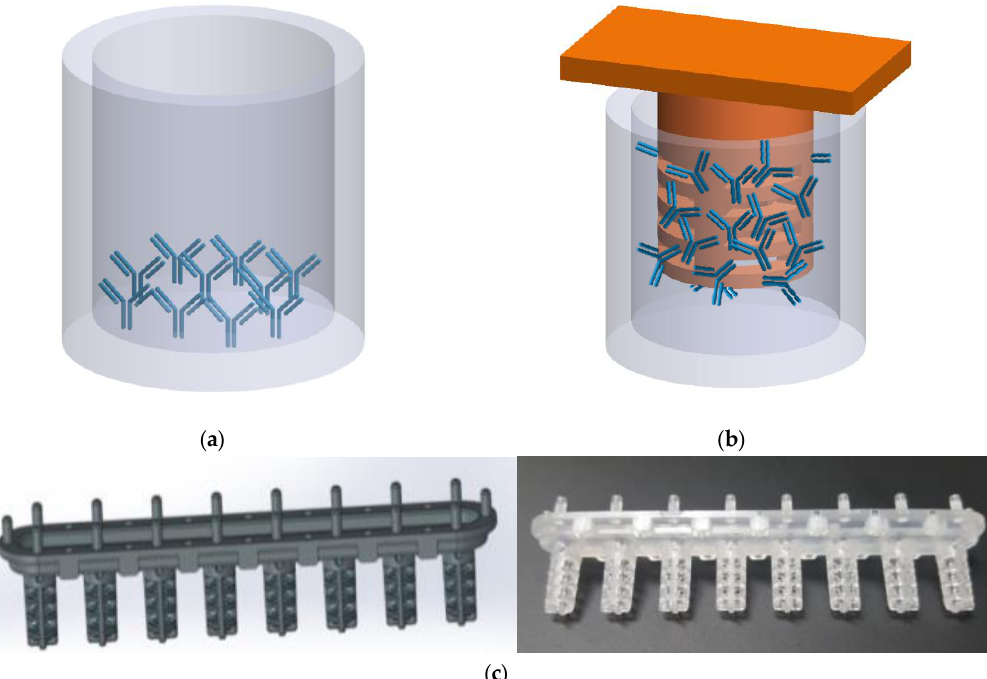
Figure 1. Schematic of plastic membrane design for this study. ( a ) Most antibodies are conjugated on the bottom surface in a conventional ELISA well plate, ( b ) the fabricated membrane increases the surface area where antibodies are conjugated, and ( c ) a designed and fabricated meshed type plastic membrane.